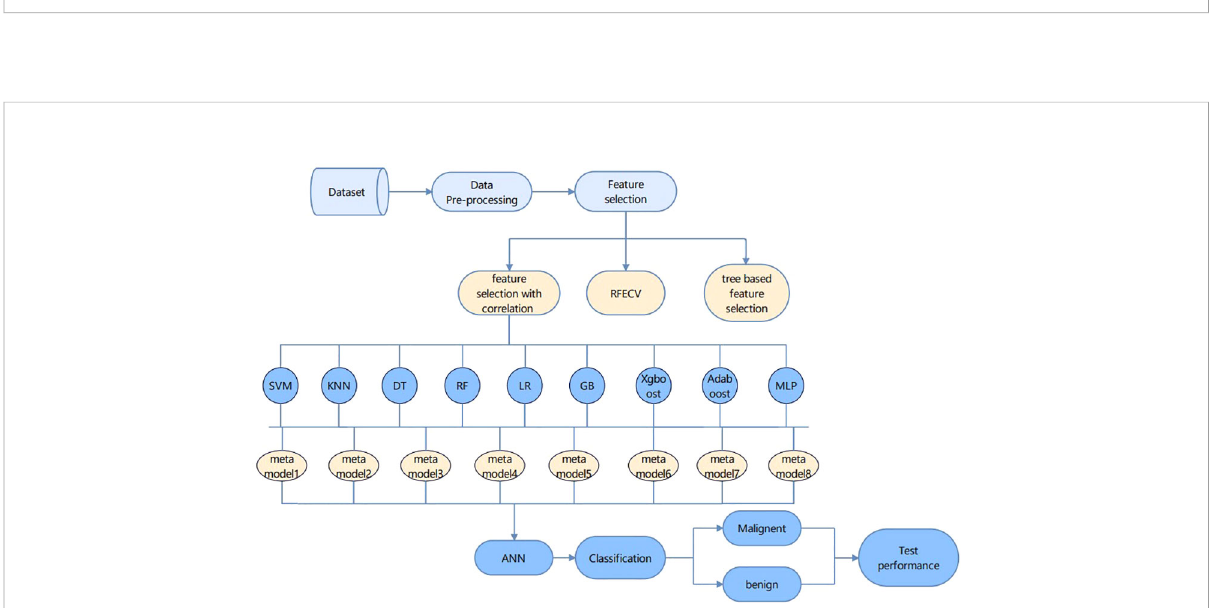
FIGURE 3 Arti fi cial neural network